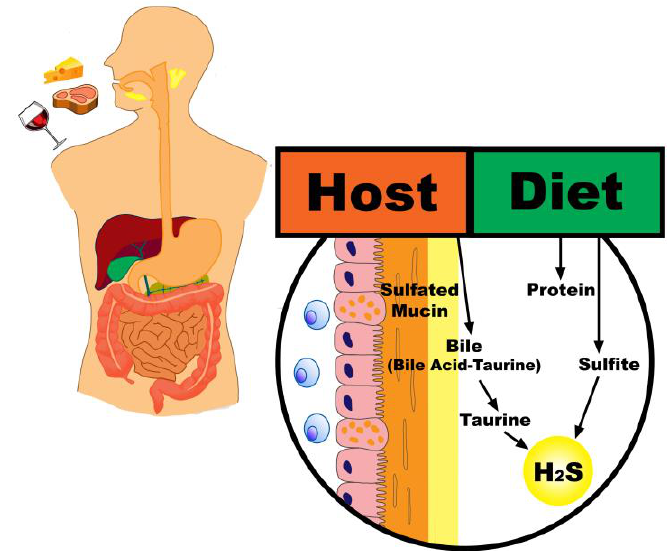
Figure 1. Contributions of an animal-based diet to hydrogen sulfide production. Legend: An animal-based diet results in a greater amount of dietary sulfur available to distal gut microbiota, both directly through sulfur-containing amino acids and indirectly through an increase in taurine conjugated bile acids and mucin